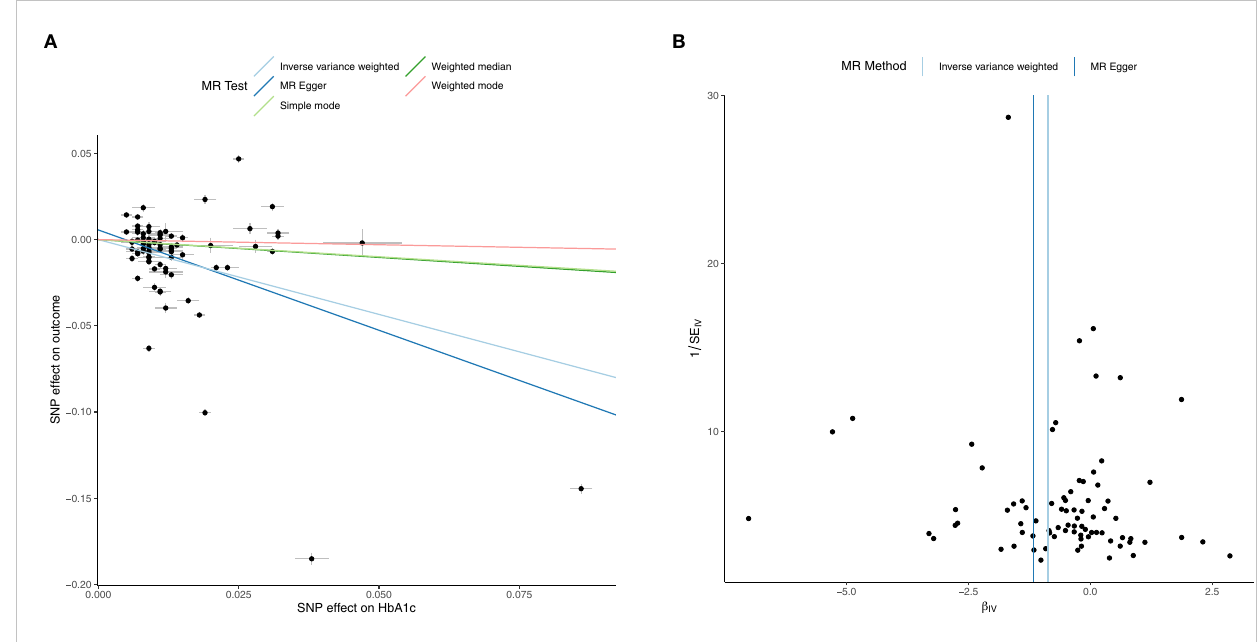
FIGURE 1 Univariable Mendelian Randomization (MR) Analysis — Exposure: fasting insulin (FI), Outcome: hemoglobin (Hb) — (A) Scatter plot showing the single nucleotide polymorphisms (SNPs) associated with FI against SNPs associated with Hb (vertical and horizontal black lines around points show 95% con fi dence intervals (CI) for fi ve different Mendelian Randomization (MR) association tests (B) Funnel plot of the effect size against the inverse of the standard error for FI against